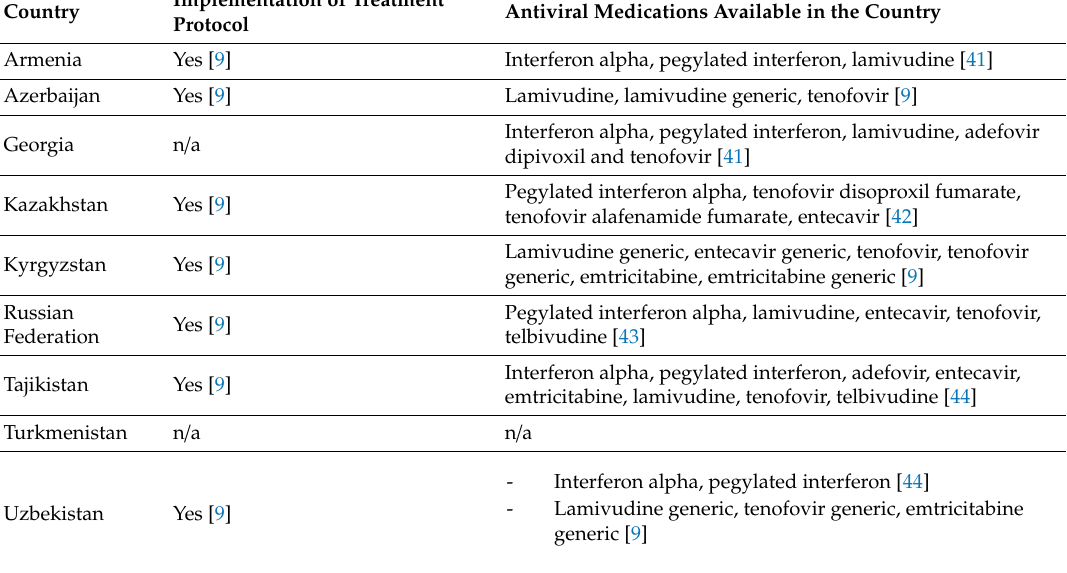
Table 4. Implementation of HBV treatment in the countries of Central Asia and the Caucasus. n / a, not available. Implementation of Treatment Country Antiviral Medications Available in the Protocol